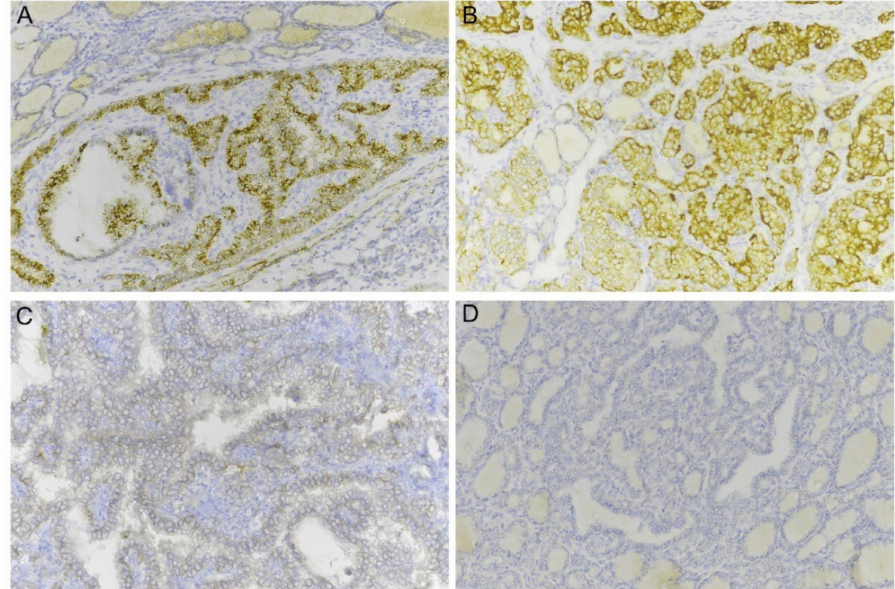
Figure 1. Pan-Trk IHC in papillary thyroid carcinoma. A strong granular cytoplasmic immunore- activity is evident in neoplastic cells of a classical PTC carrying a ETV6/NTRK3 rearrangement ( A ); strong immunoreactivity is clear and specific in cell membrane and cytoplasm of neoplastic cells in a case of NTRK3 -rearranged classical PTC ( B ); weak and focal immunopositivity for pan-Trk in a case of classical PTC that was negative for NTRK rearrangements ( C ); no immunoreactivity is observed in a case of follicular variant PTC that was positive for the ETV6/NTRK3 rearrangement ( D